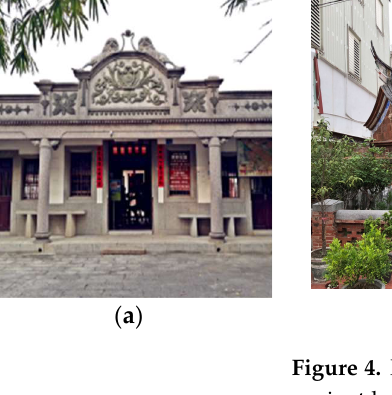
Figure 4. Rural cultural tourism played an important role during COVID-19. ( a ) The Xiao family ancient house was built over 200 years ago and has now become a cultural heritage; ( b ) The gate of the ancient house for defense. Here, a real war happened in 1895 in the Japanese occupation era; ( c ) groundwater for everyday life with furui (traditional pump); and ( d ) Gossip gate, a form of “Feng Shui” in Chinese, which means the gate can foster the safety and health of all families.